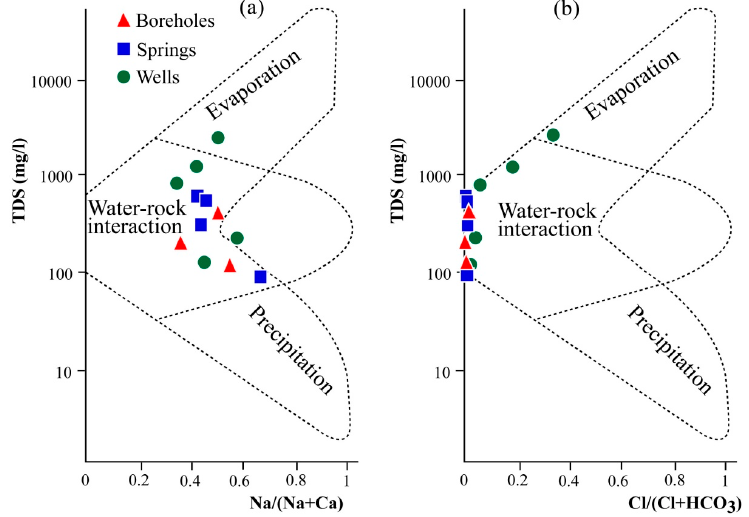
Figure 4. Gibbs [42] plots indicating water-rock interaction as the main process regulating the chemistry of waters in the study area. (a) TDS versus Na/(Na+Ca) diagram; (b) TDS versus Cl/(Cl+HCO 3 ).